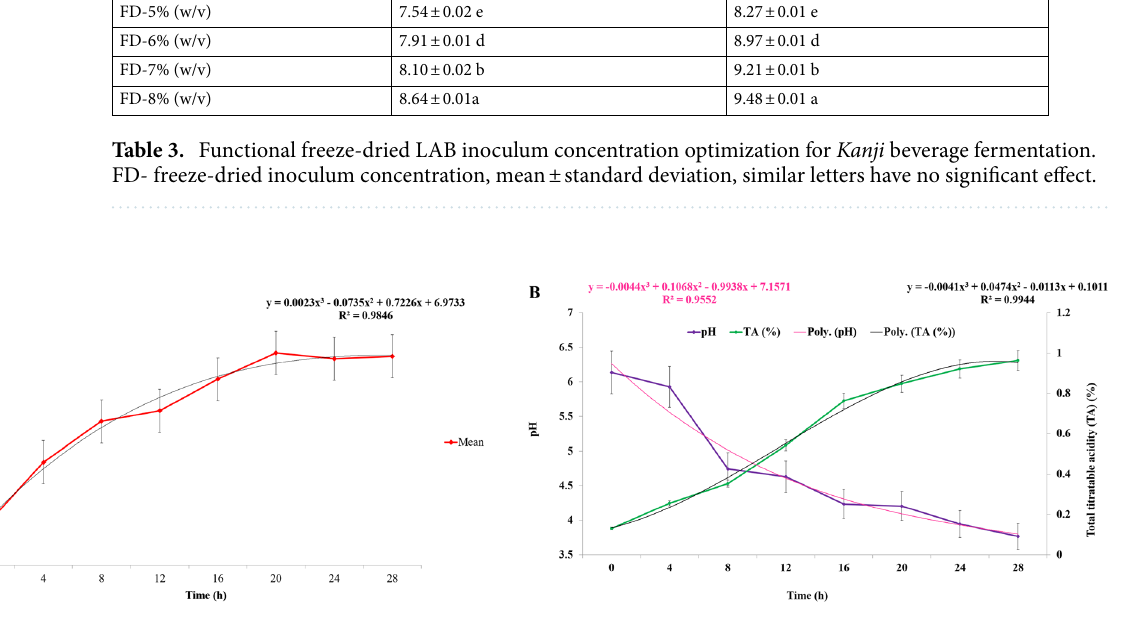
Figure 2. ( A ) The amount of microbial (lactic acid bacteria), ( B ) pH and total titratable acidity during LAB fermentation of Kanji beverage reconstituted at 10:60